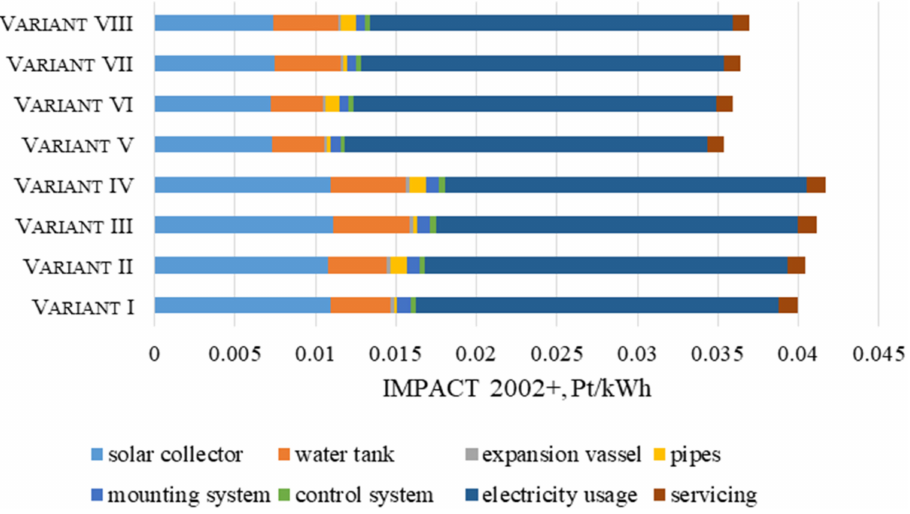
Figure 4. Results of IMPACT 2002+ calculation per functional unit,